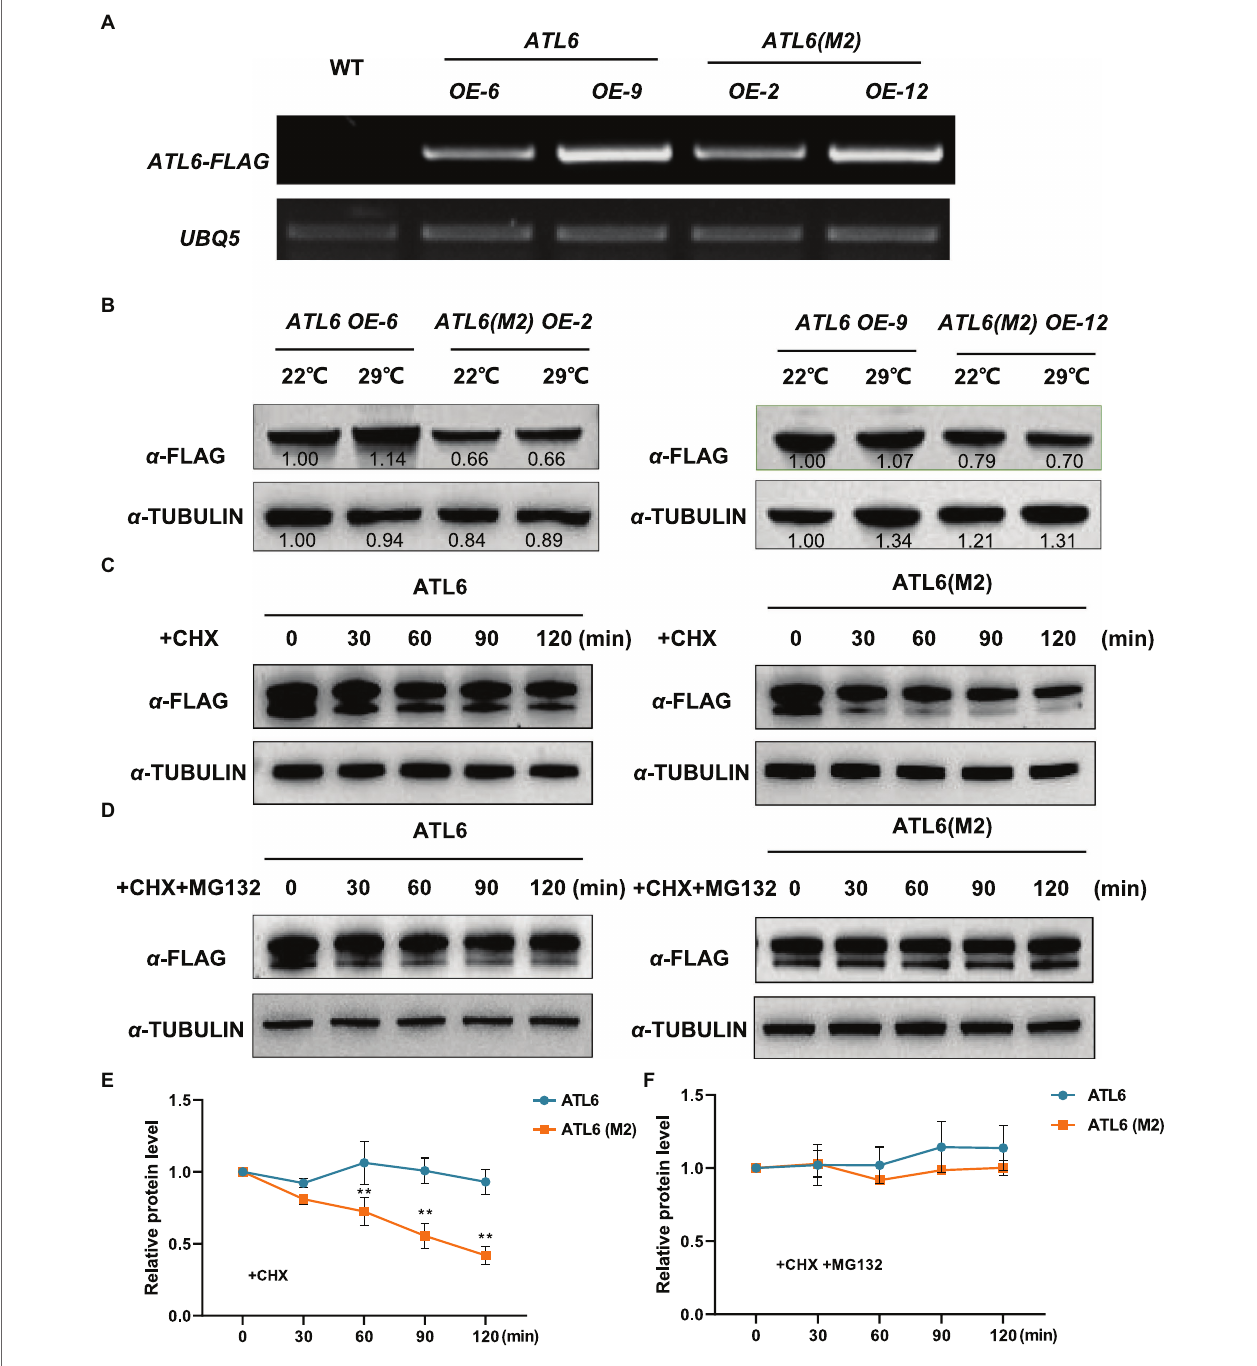
FIGURE 5 | Protein stability of the native and mutated forms of ATL6 in response to warm temperature. The FLAG-tagged native form ( ATL6 ) or the mutated form ATL6(M2) (S343A S357A) was overexpressed in Arabidopsis , and the transgene expression was validated by RT-PCR (A) . Two-day-old plants were grown at 22 ° C and 29 ° C for 3 h, and the accumulation of ATL6-FLAG or ATL6(M2)-FLAG was checked by western blotting analysis (B) . The protein stability of the native or mutated form of ATL6 was investigated in the cell-free degradation assays (C–F) . Signal intensity of each band was quantified and normalized to that of the first sample. Relative protein level is the quantified signals of ATL6 normalized to that of TUBULIN from three western blots. The bars depict the SE ( n = 3). **Significant in t -test ( p < 0.01). Cycloheximide (CHX) was used to inhibit protein synthesis and MG132 is an inhibitor of the 26S